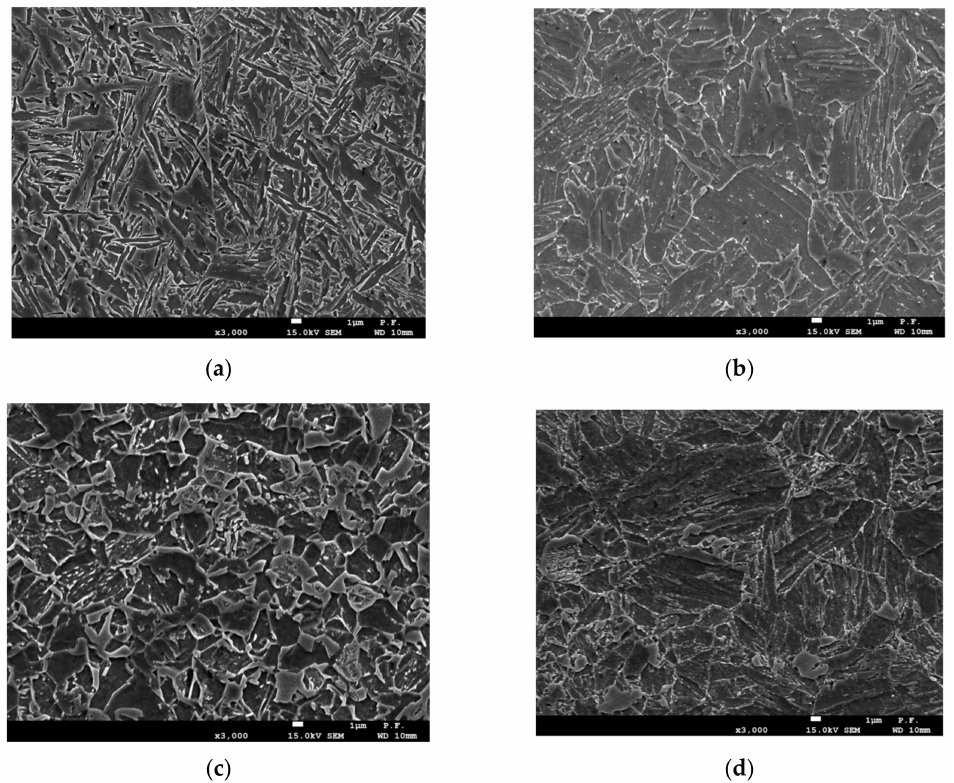
Figure 5. Microstructure in joint welded according to Q 3: ( a ) WM; ( b ) HAZ1; ( c ) HAZ2; ( d ) HAZ3.